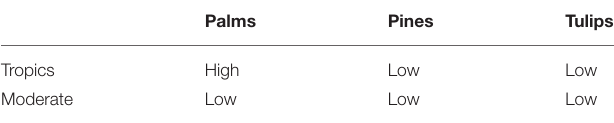
TABLE 2 | Similarity values for the three CWs. Palms Pines Tulips Tropics High Low Low Moderate